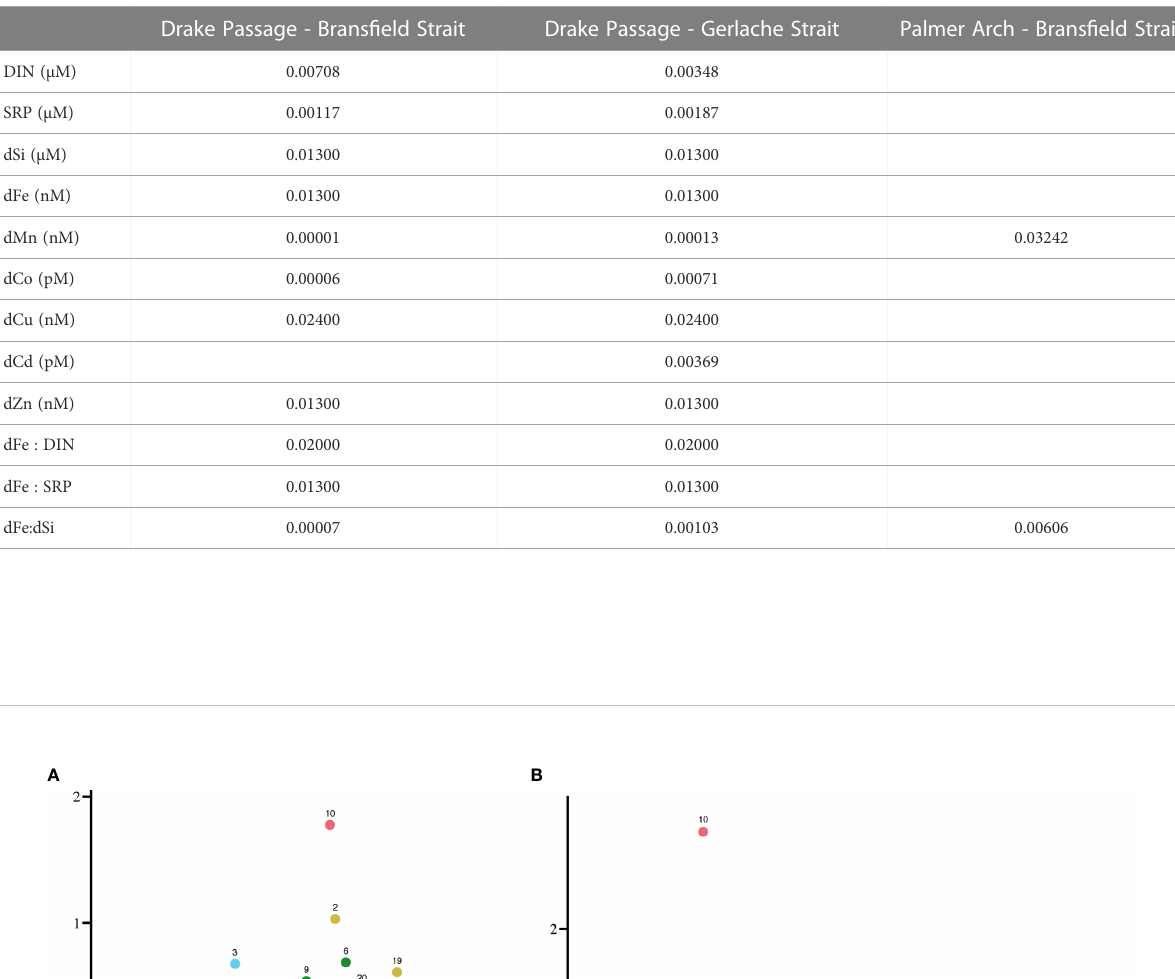
TABLE 2 Adjusted p -values of pairwise comparisons between groups that were < 0.05 for the environmental parameters including dissolved inorganic nitrogen (DIN), soluble reactive phosphorus (SRP), dissolved silicic acid (dSi), dissolved iron (dFe), dissolved manganese (dMn), dissolved cobalt (dCo), dissolved copper (dCu), dissolved cadmium (dCd), and dissolved zinc (dZn).